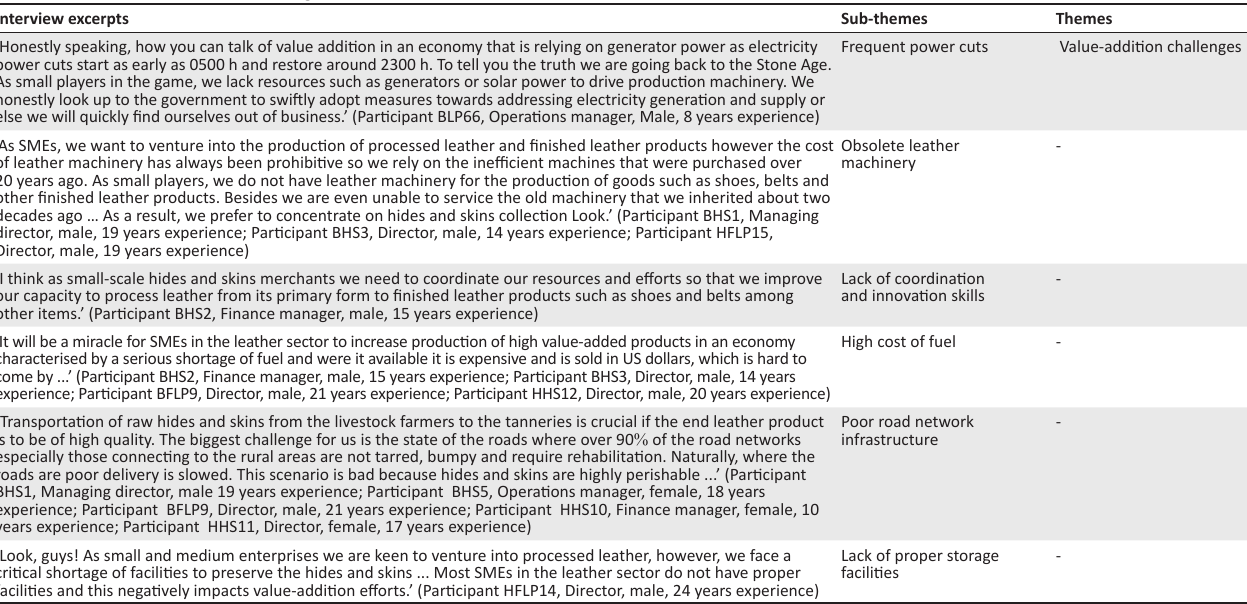
TABLE 4: Theme 2 value-addition